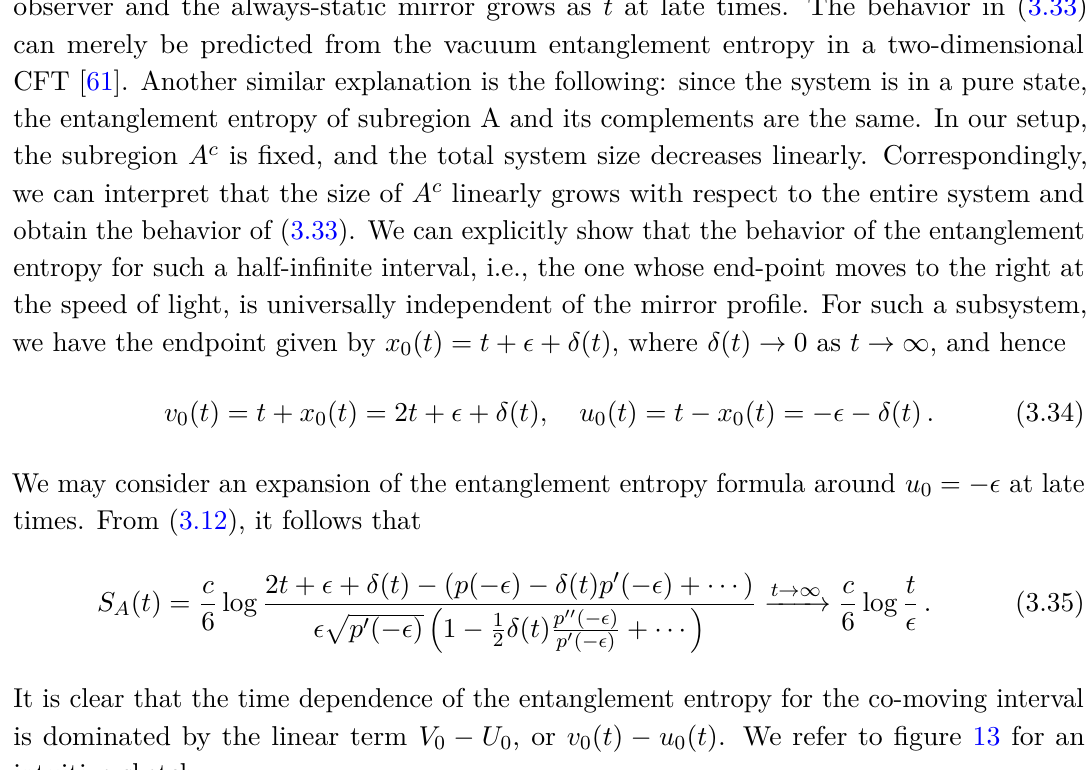
Figure 13 . The physical interpretation for the universal behavior of entanglement entropy for a co-moving interval in the case of type C mirrors. At late times, the distance v endpoint of a co-moving interval grows linearly and results in eq. (3.35) for the time evolution of the entanglement